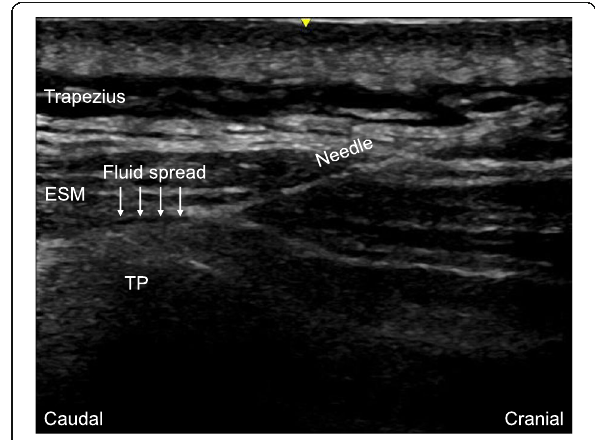
Fig. 1 Ultrasound image of erector spinae plane block. The end point is the visible spread of the local anesthetic fluid, resulting in the lifting of the erector spinae muscles. ESM erector spinae muscles, TP transverse